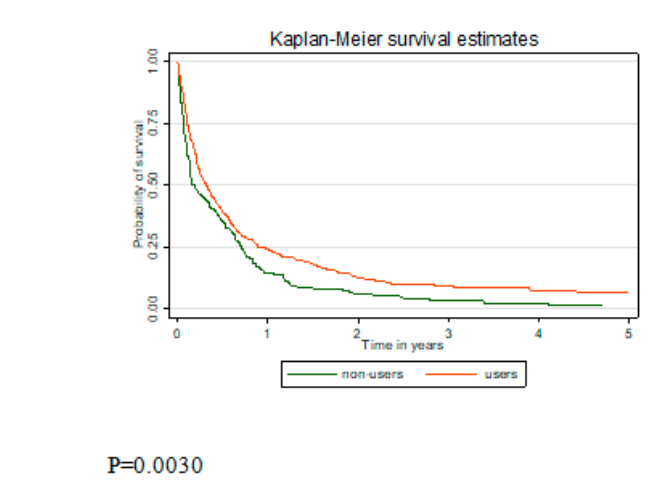
Figure 1. Kaplan–Meier survival curve comparing overall survival between diabetic metformin users and metformin non-users.